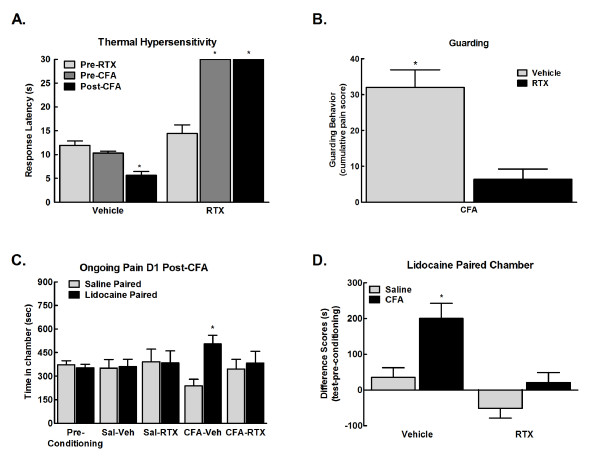
A. RTX (0.1 mg/kg, i.p.) treatment 4 days prior to testing blocked thermal nociception with all responses on the hot plate (52°C) reaching the cut-off time (32 s). CFA reduced the thermal response latency within 24 hr in animals that received vehicle for RTX. Thermal hypersensitivity was completely blocked in the RTX treated group. *p < 0.05 vs. pre-RTX; #p < 0.05 vs. vehicle, n = 7. B. RTX treatment 4 days prior to testing blocked CFA induced guarding of the hindpaw observed 24 hours following injury. *p < 0.05 vs. vehicle treated, n = 8-10. C. RTX treatment 1 day prior to testing prior to habituation blocked CPP to chambers paired with lidocaine administration into the popliteal fossa in CFA treated rats 24 hr post-CFA. Rats that received saline into the hindpaw failed to show preference for the lidocaine paired chamber irrespective of RTX treatment. *p < 0.05 vs. pre-conditioning, n = 6-8. D. Difference scores calculated as test time - preconditioning time spent in lidocaine chamber confirm that only CFA treated rats that did not receive RTX (Vehicle) showed preference for the lidocaine paired chamber. *p < 0.05 vs. saline treated group.